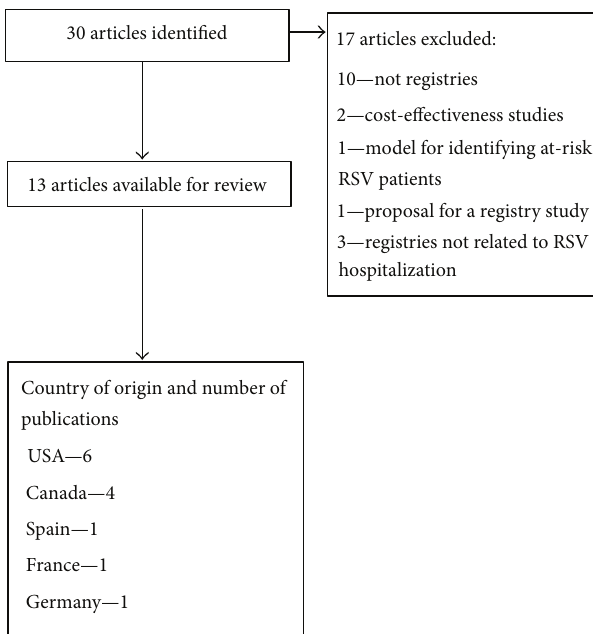
Figure 1: Flow chart of assembled articles from the scientific literature.